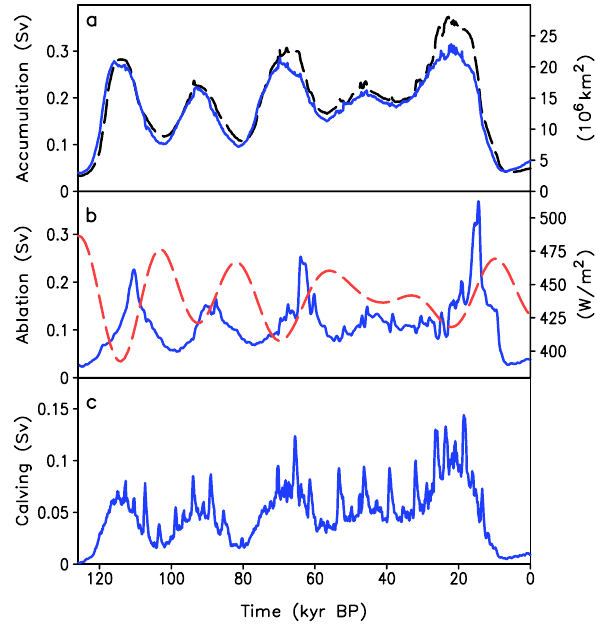
Fig. 6. Simulated NH time series. (a) Ice volume, (b) ice area and (c) fraction of the ice sheets temperate basal area. The black line shows the time series of the entire NH, the blue line of the North American and the red line of the European ice sheets.